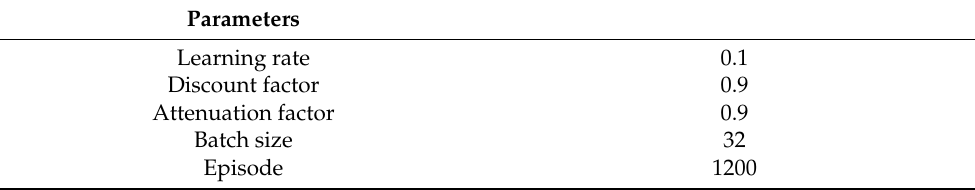
Table 3. The parameters for the DQN method.